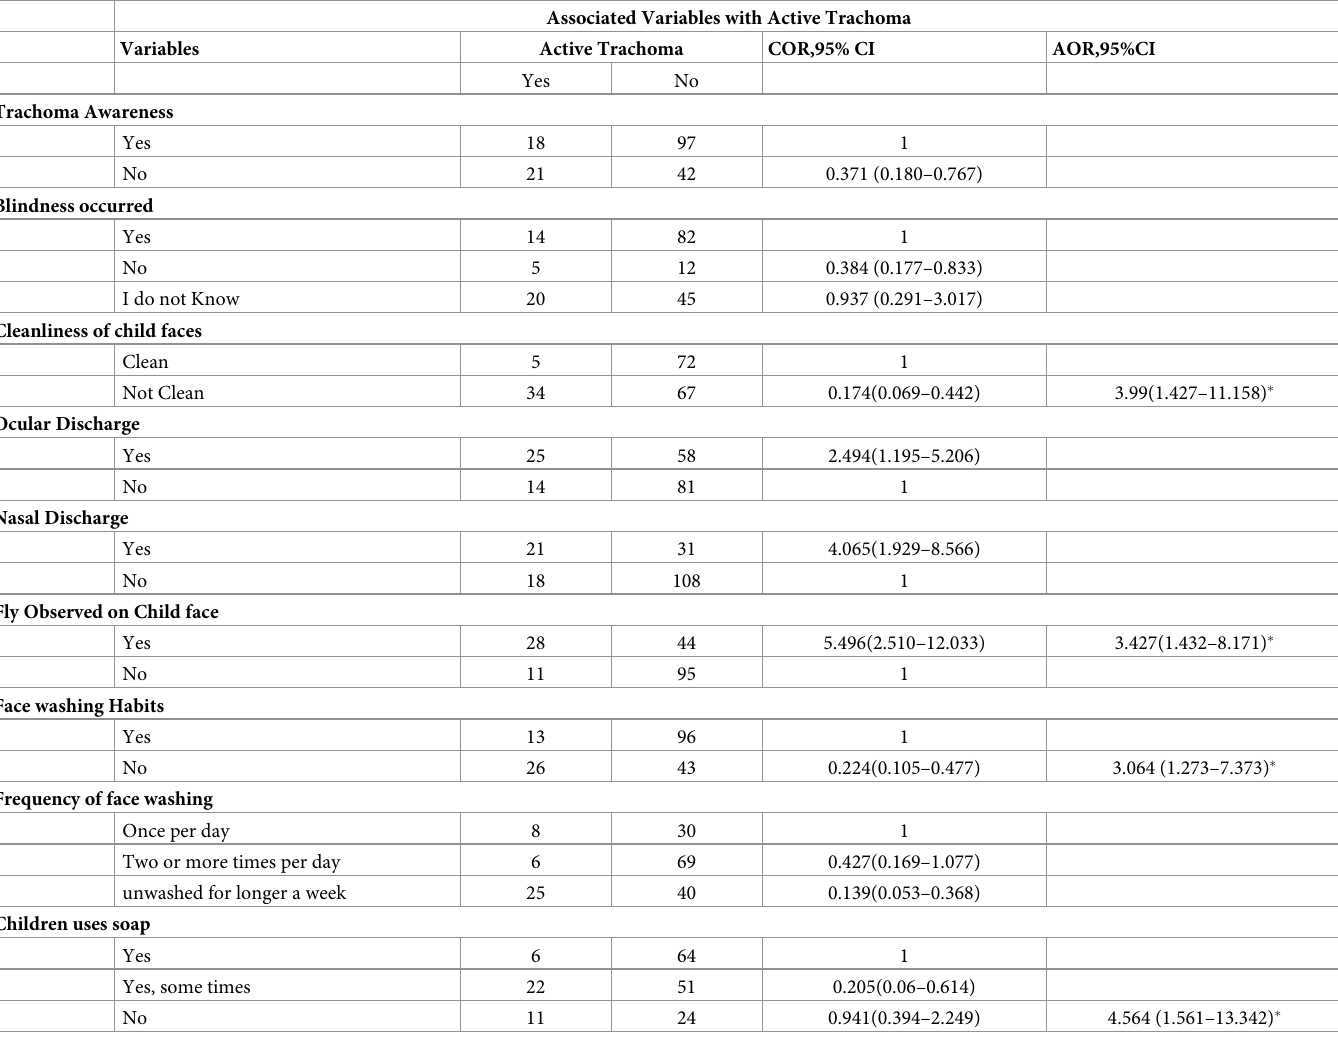
Table 6. Variables associated with active trachoma among children aged 1–9 years at Arsi Negele Town, West Arsi, Oromia, Southern Ethiopia, December 2019. Associated Variables with Active